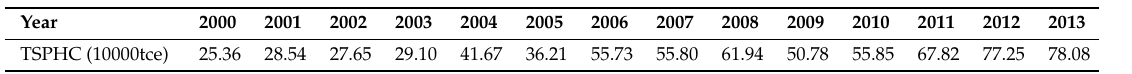
Table 4. The electric power consumption of the Transport, Storage and Post industry in China (2000–2013).